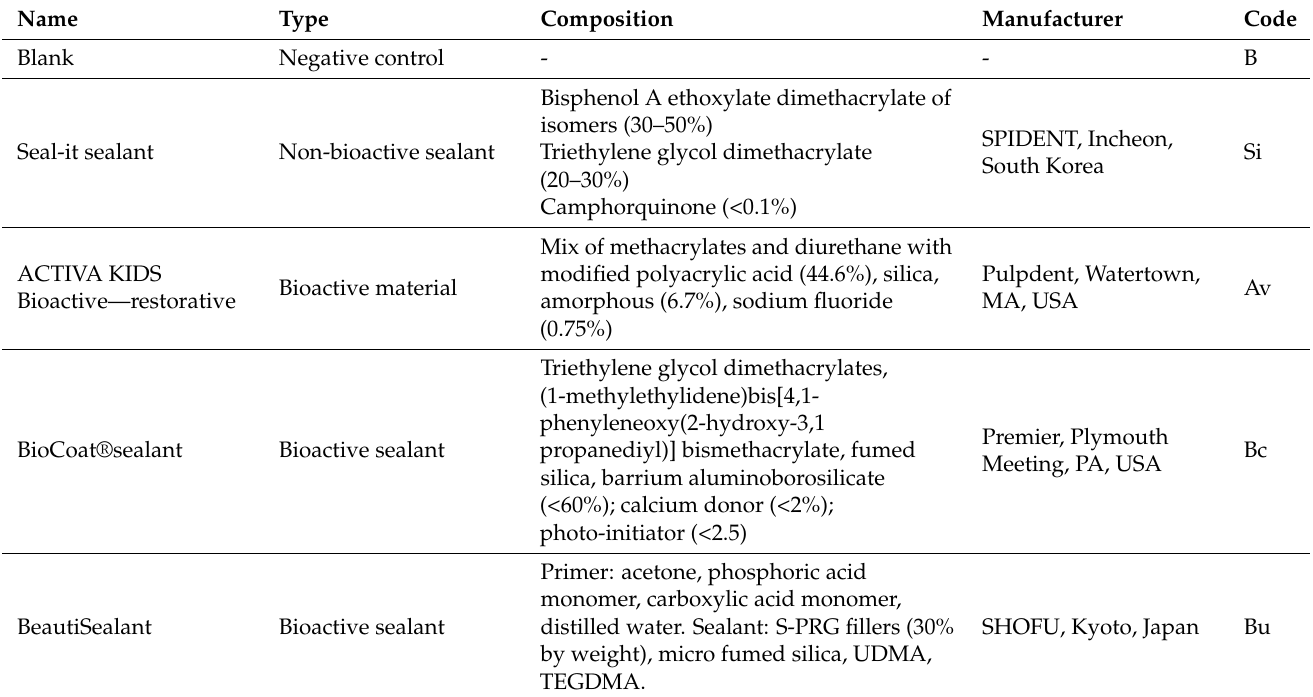
Table 1. Studied